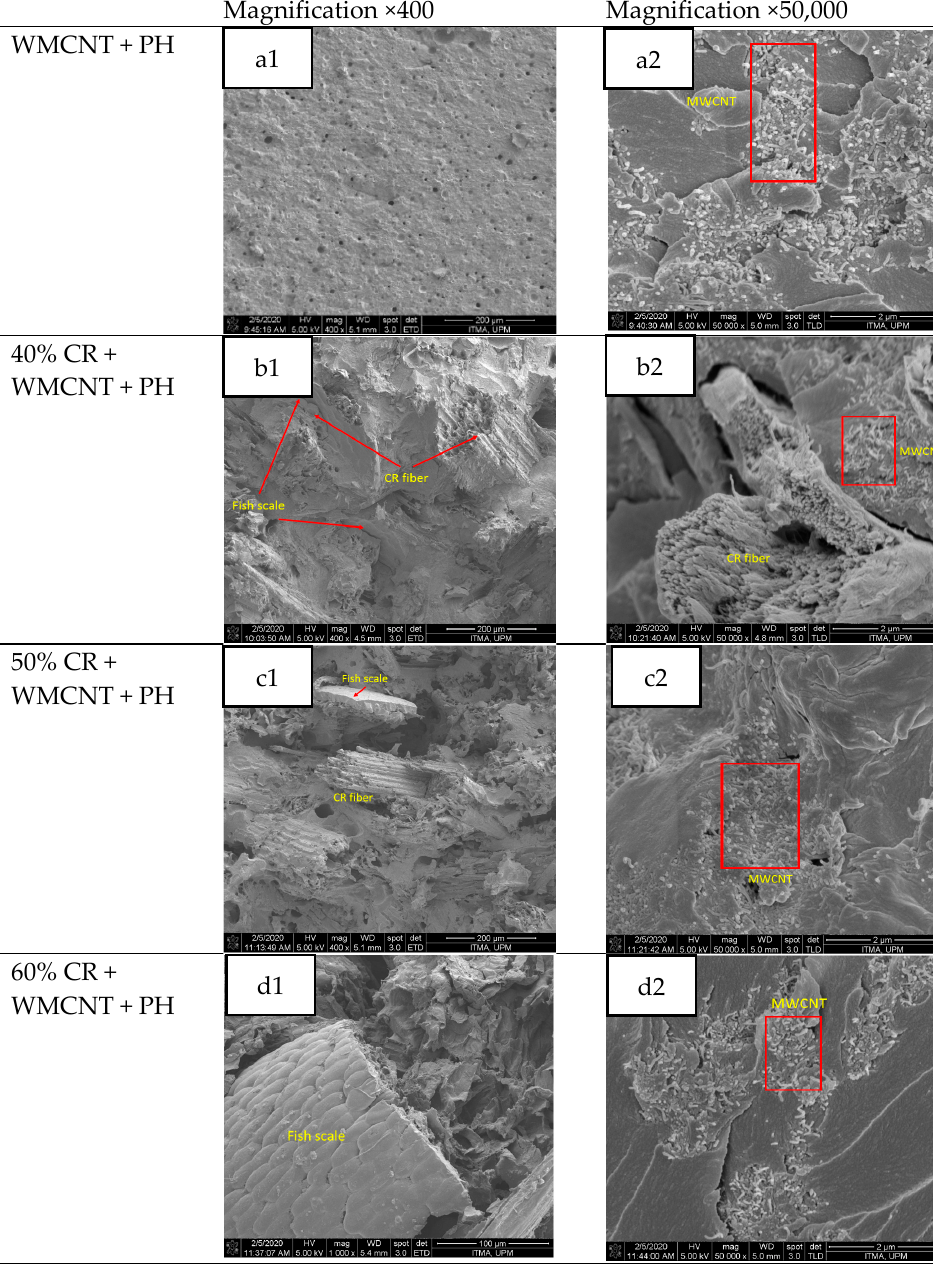
Figure 8. FESEM micrographs of the bio-composites filled with MWCNT and CR fiber ( a1 , a2 ) MWCNT + PH, ( b1 , b2 ) 40% CR + MWCNT + PH, ( c1 , c2 ) 50% CR + MWCNT + PH, ( c1 , c2 ) 50% CR + MWCNT + PH, ( d1 , d2 ) 60% CR + MWCNT + PH.